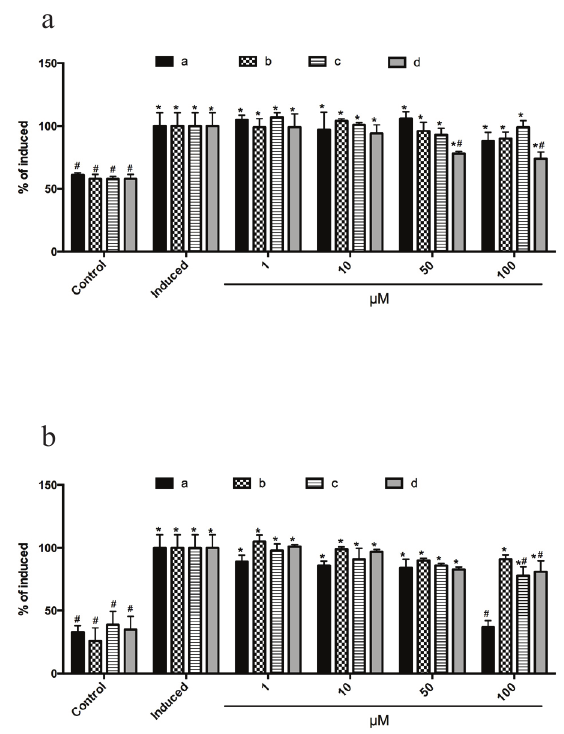
Figure 2 - Effect of compounds a - d on lipid peroxidation induced by SNP in the brain (a) and liver (b) of mice. Data are reported as mean ± S.E.M. Statistical analysis was performed by One-way ANOVA followed by Newman-Keuls’ test. (*) denotes P < 0.05 when compared to the control group. (#) denotes P < 0.05 when compared to the induced